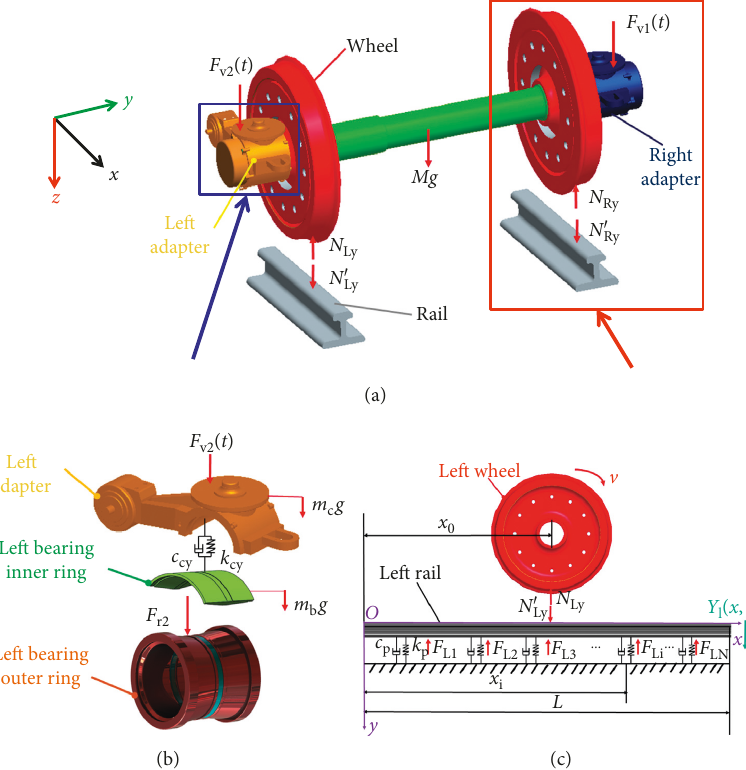
Figure 1: General force diagram of the dynamic system: (a) force diagram of the bearing-wheel-rail system; (b) force diagram of the adapter- bearing system; (c) force diagram of the wheel-rail system.